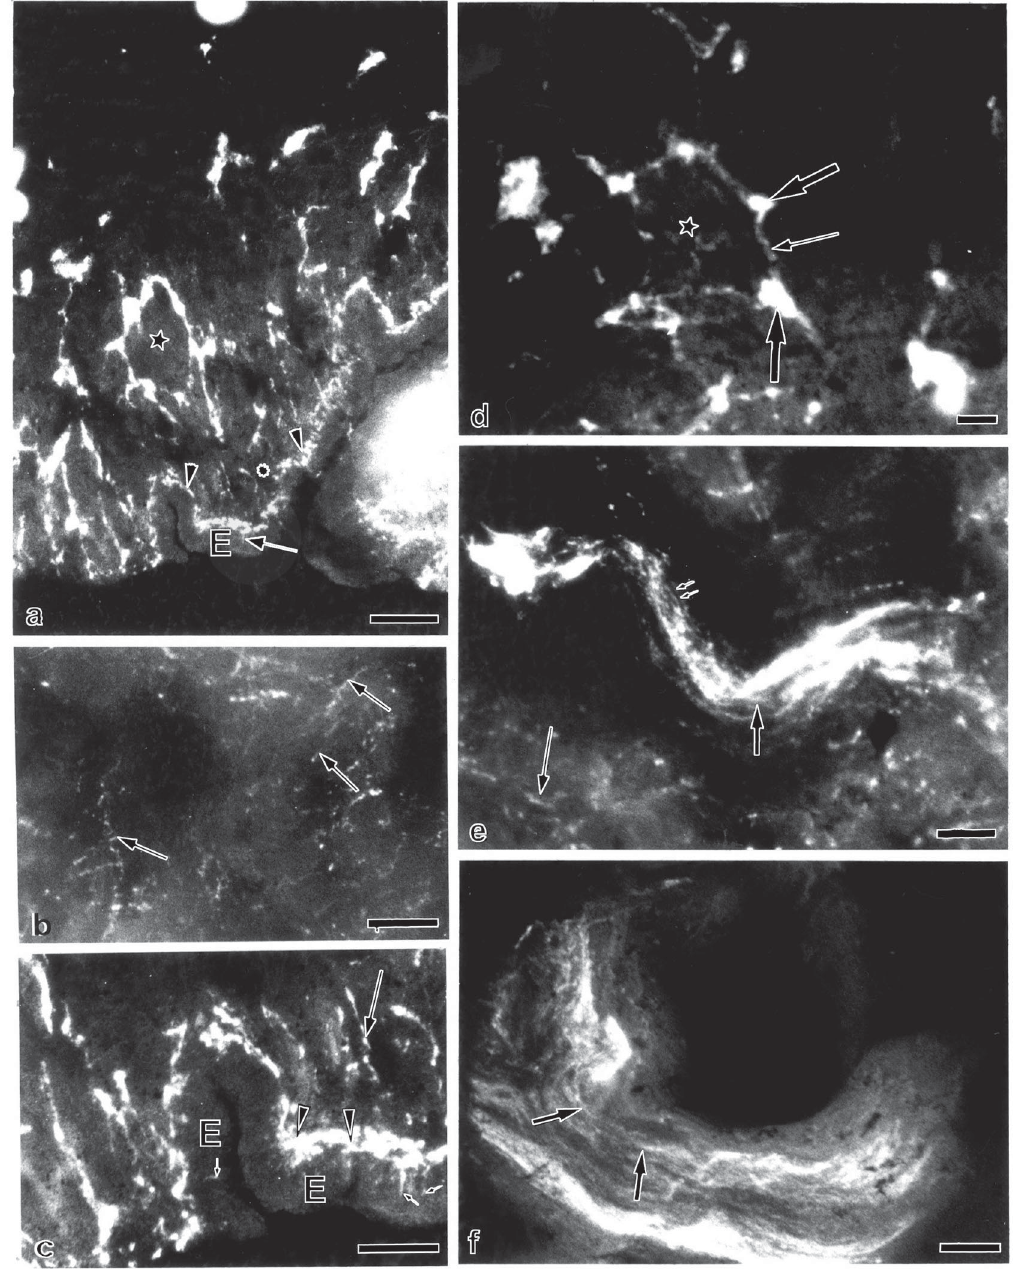
Figure 1. Fluorescent micrographs of the ventral aspect of Megalobulimus oblongus showing catecholamine (CA) and 5-hydroxytryptamine (5-HT) fluorescence in the pedal plexus. a , Note a dense mesh of CA-labeled fibers (arrowheads) against the ventral epithelium (E) and a loose CA network in the middle region of the pedal muscle that corresponds to the pedal plexus (star). From the subepithelial plexus (asterisk) some neuronal distal processes separated and penetrated between the epithelial cells (thin arrow). b , Section from the middle region of the pedal muscle showing 5-HT fluorescent varicose axons (arrows). c , Detail from a . Note the intense CA fluorescent subepithelial cells (arrowheads) from which some processes (thin arrow) penetrate between the epithelial cells (E). d , Detail of the pedal plexus (star). Observe CA fluorescence in ganglia (arrows) and in nerves that form the mesh (small arrow). e , Note nerves longitudinally sectioned with CA (arrow) and 5-HT (double arrow) fluorescent axons. Observe 5-HT fluorescent axons (thin arrow) in another nerve. f , A nerve over the muscle cells with CA fluorescent fibers (arrows). Bars: a = 100 µm; b, e, f = 20 µm; c, d = 50